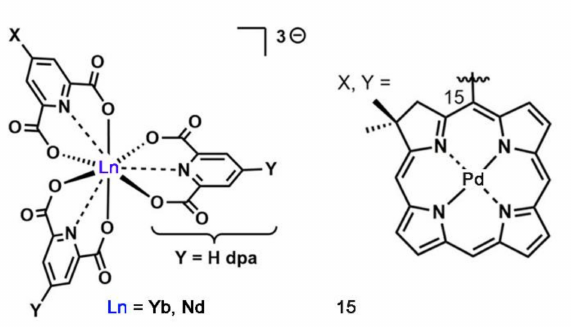
Figure 6. Structures of Yb and Nd complexes. Reprinted with permission from [42]. Copyright 2018, American Chemical